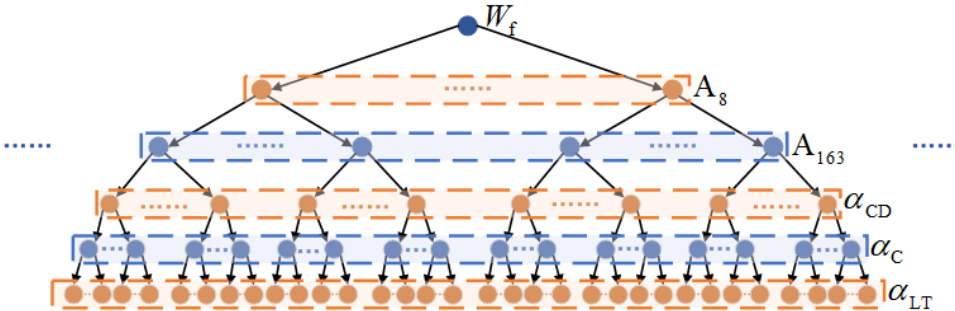
Figure 3. Structure diagram of multifurcating tree